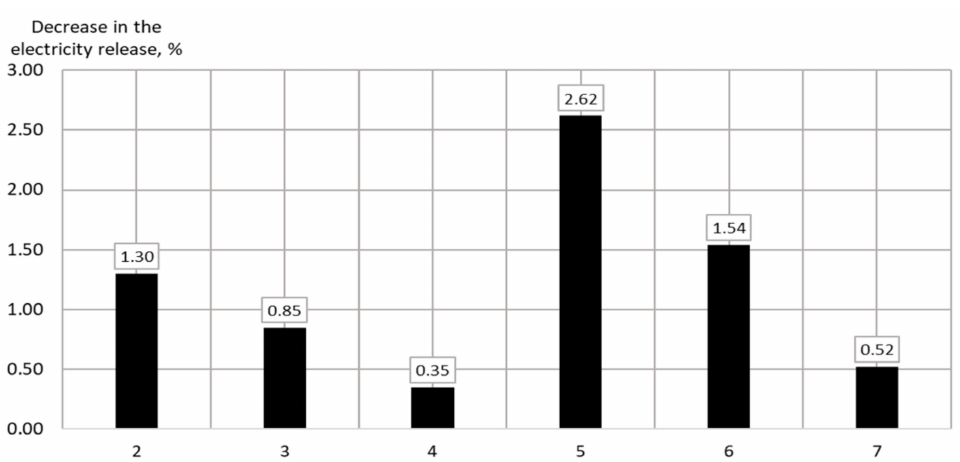
Figure 9. Decrease in the electricity release with integrated